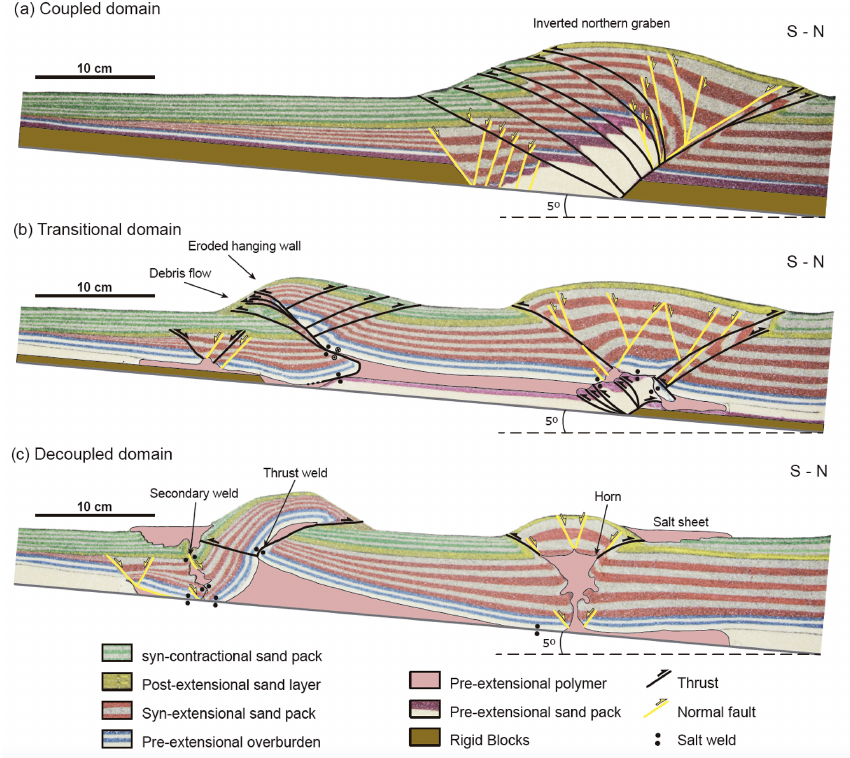
Figure 9. Cross-sections at the end of the model 3 (after 200mm of shortening) showing the structural style at the different domains. (a) Coupled domain; (b) transitional domain; (c) decoupled domain. See Fig. 8d for location. After the deposition of each syn-compressional sand layer, the rig was tilted 0.2 ◦ to the north up to an additional 2.2 ◦ to simulate the orogenic flexure of the Basque–Cantabrian